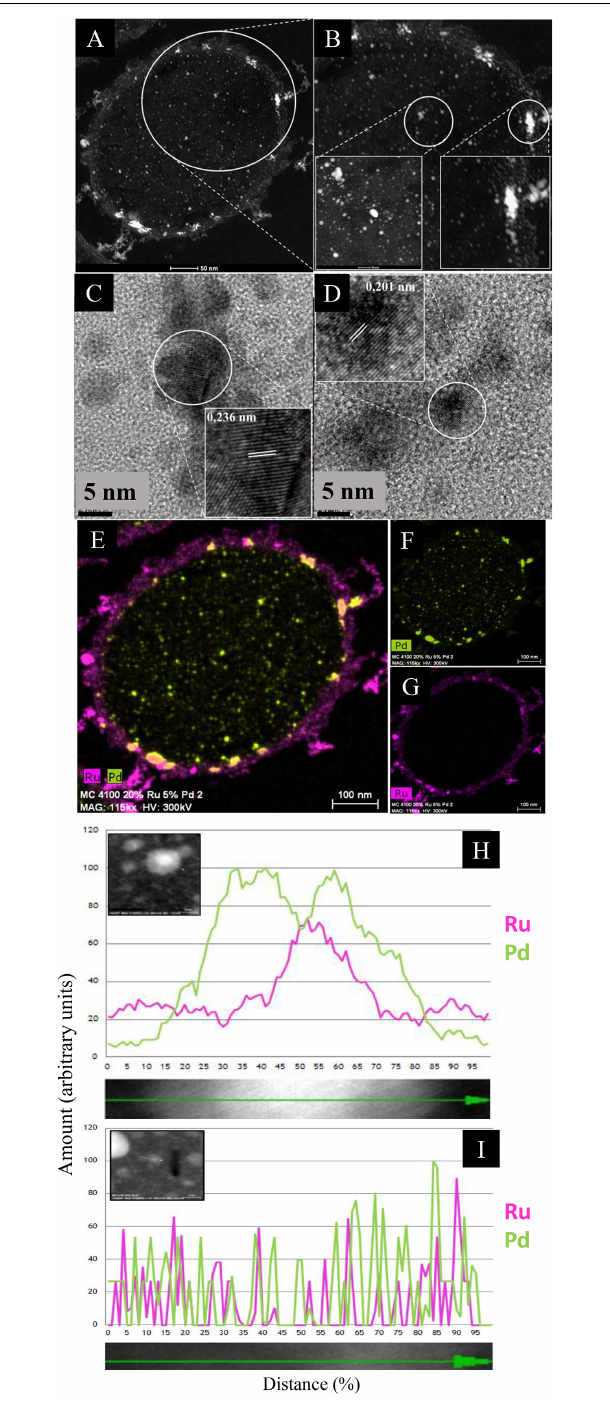
FIGURE 3 | HAADF/STEM micrographs of cell sections showing Pd/Ru NPs (5 wt% Pd/20 wt% Ru). (A) A higher magnification panel (B) shows NPs located in the cell surface layers ( B , inset right) and in the bulk region ( B , inset left). Lattice spacing of example NPs in cell wall layers and intracellularly are shown in, respectively (C,D) . Elemental maps (by EDX) of cells show co-localization of Pd and Ru (E) and individually Pd (F) and Ru (G) . Elemental maps (by EDX) of a single nanoparticle showing a core/shell structure (H) and random distribution (I) of Pd and